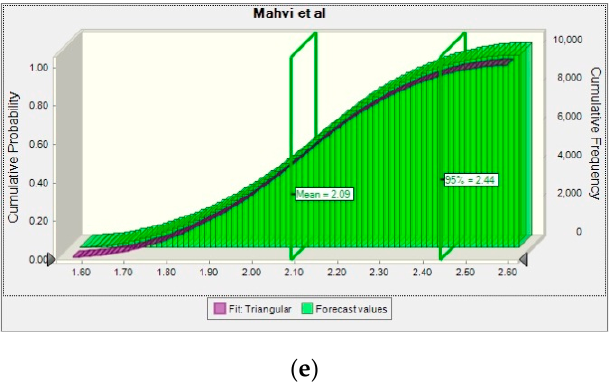
Figure 2. Cumulative probability plot of fluoride concentration (mg/L) in the different studies: (a) Amanlou et al [23], (b) Asadi et al. [27], (c) Esfahanizade et al [26], (d) Mojarad et al. [17], (e) Mahvi et al. [28]. Table 3. Chronic daily intake (CDI, mg / kg / day) and target hazard quotient (THQ) values due to exposure of men, women, and children to fluoride in consumed tea based on 95 percent percentile obtained from Monte Carlo